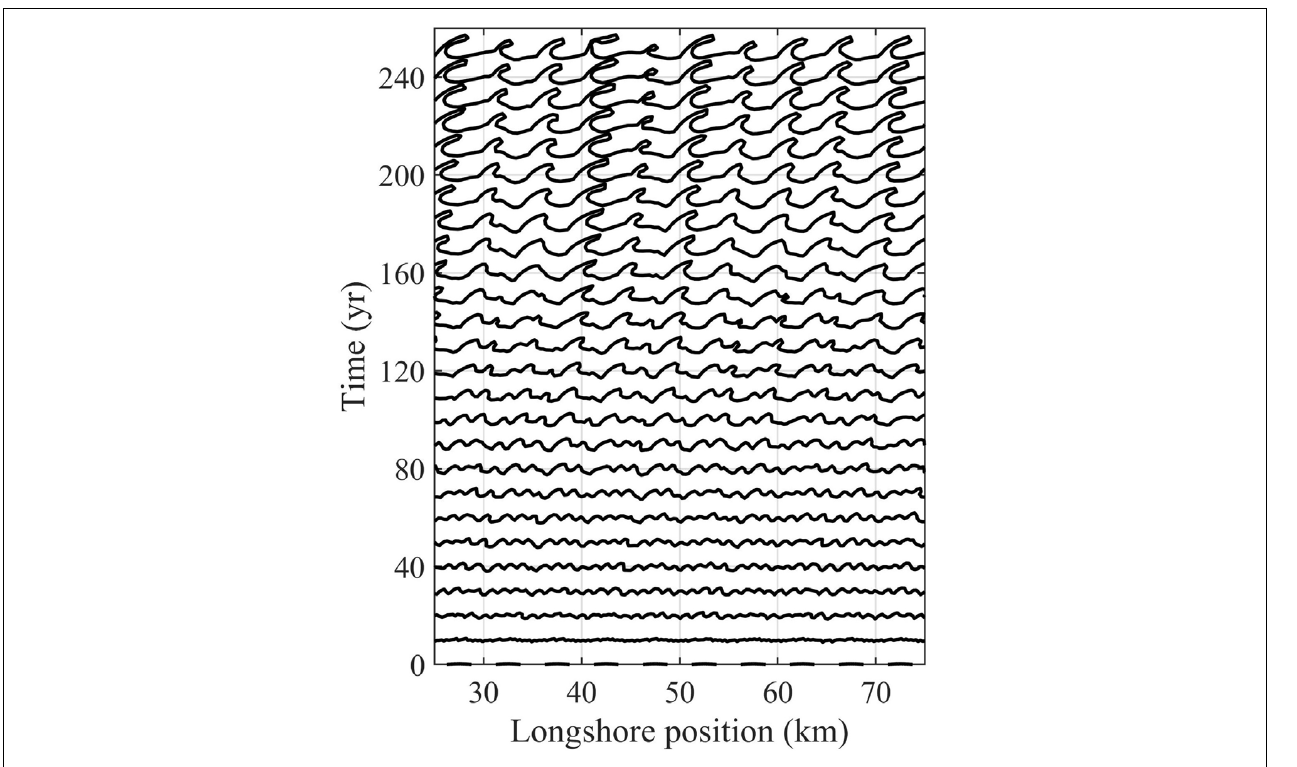
FIGURE 8 | Shoreline undulations under test conditions of Kaergaard and Fredsoe